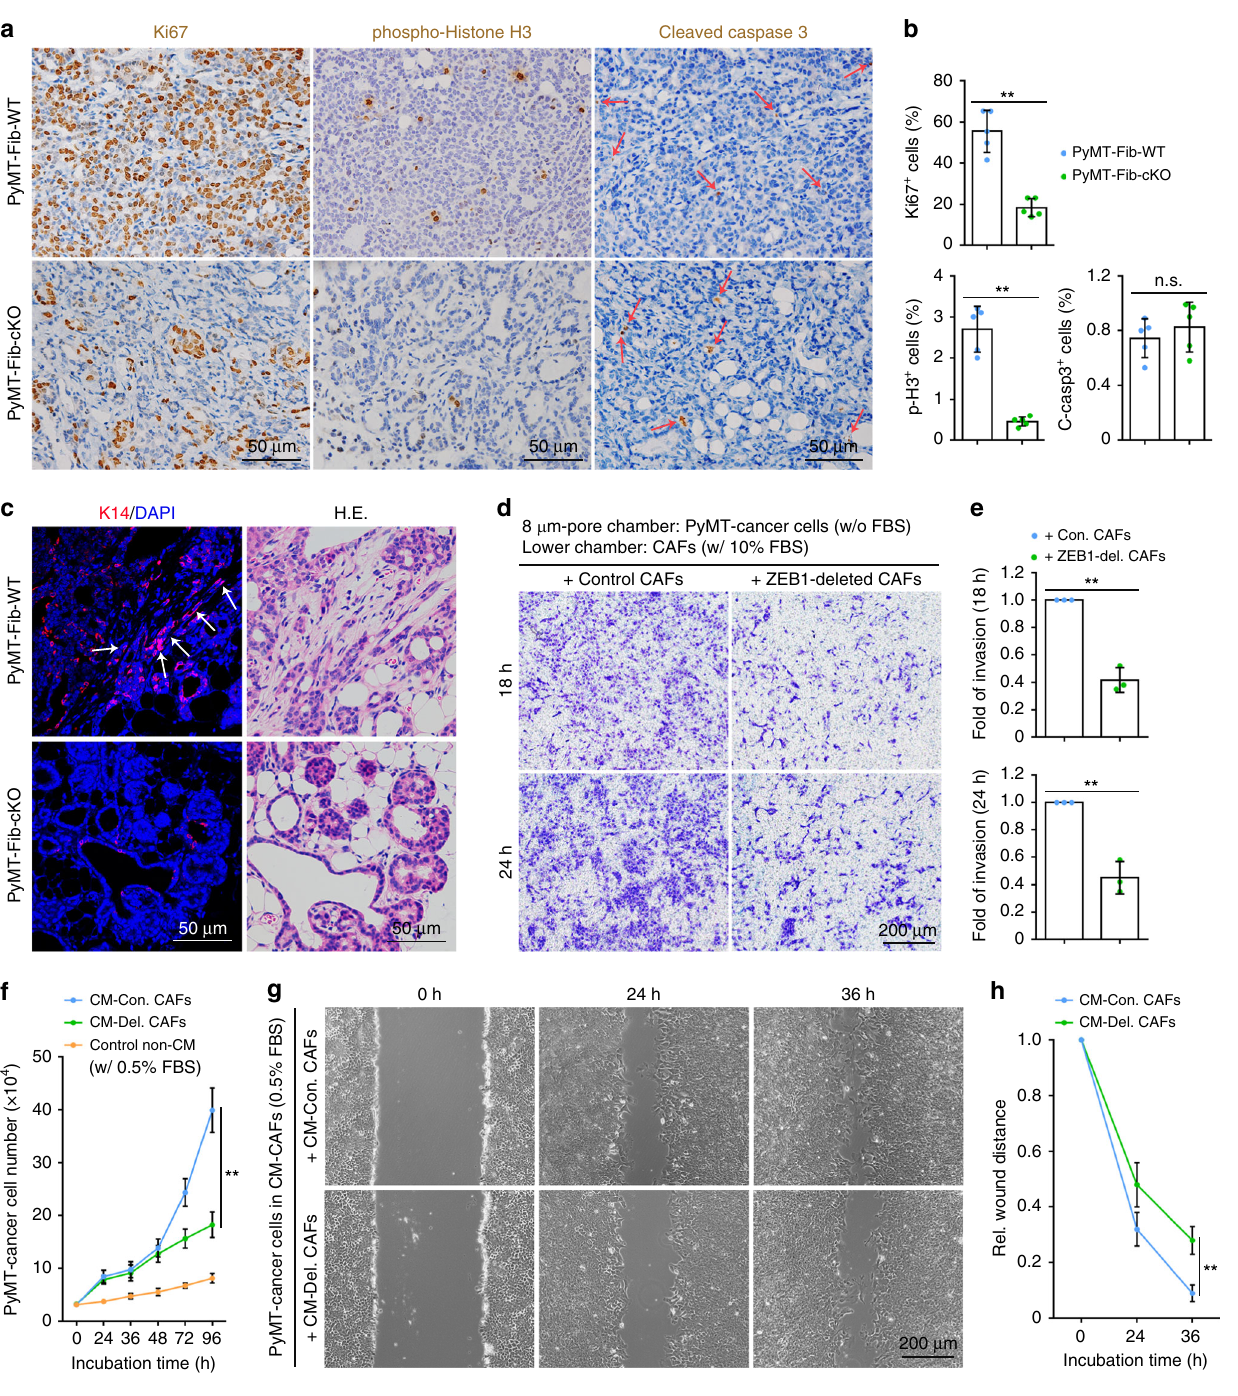
identi fi ed as the dominant p53-binding motif (Fig. 7e). In complementary studies using p53 deletion mutants, ZEB1 interacts primarily with the DNA-binding domain (DBD) of p53 (Fig. 7f, g). Earlier studies described that histone